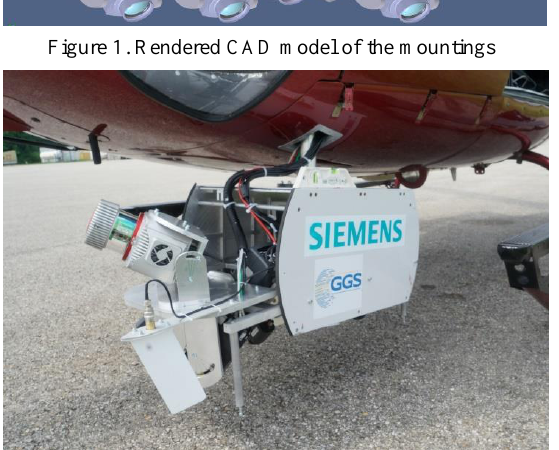
Figure 2. Sensor-head mounted on a